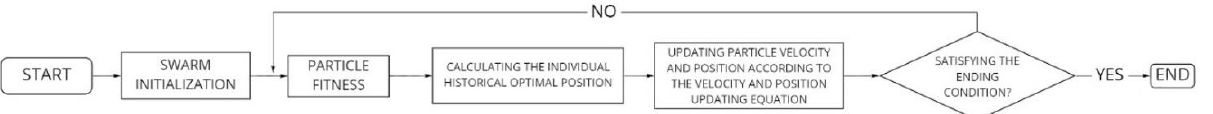
Figure 3. General functionalities of the PSO algorithm.